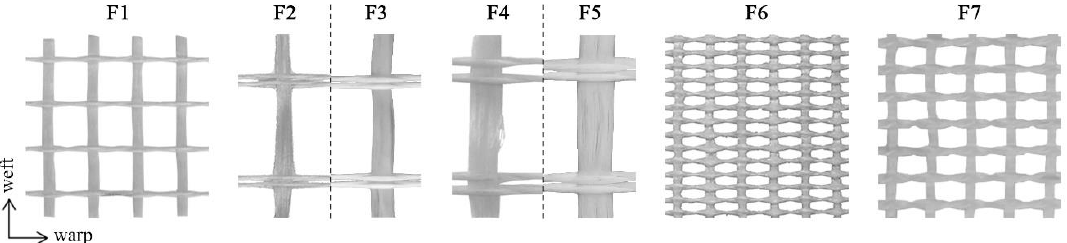
Figure 1. Overview of the investigated alkali-resistant glass fabrics (70 × 70 mm 2 samples).